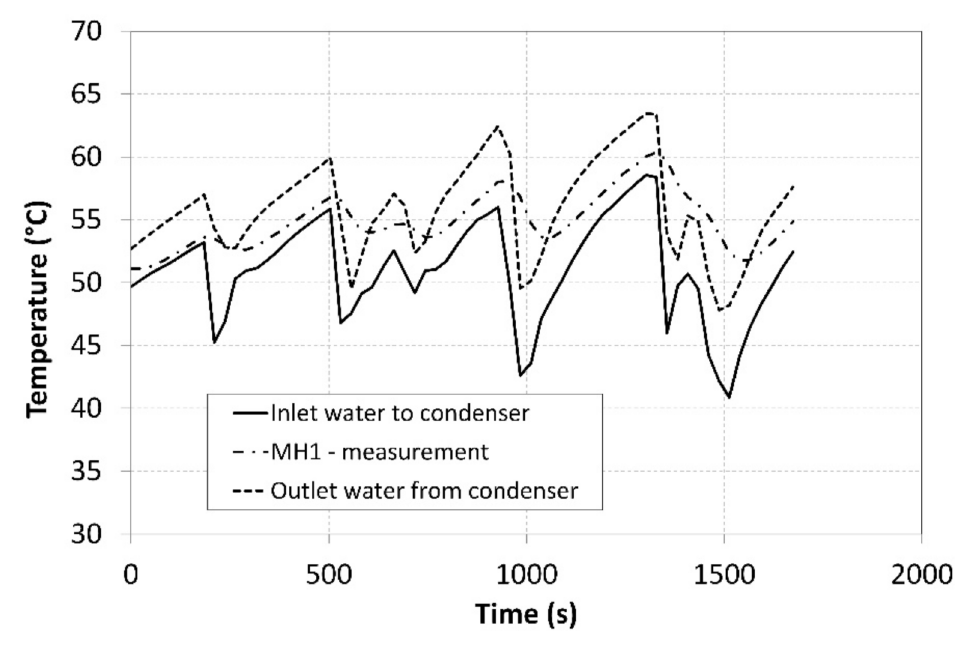
Figure 11. Thermal management of heating the MH1 tank. These curves were used to identify the instantaneous heating power and cooling power achieved in the heating and cooling processes while using the calorimetric equation (Figure